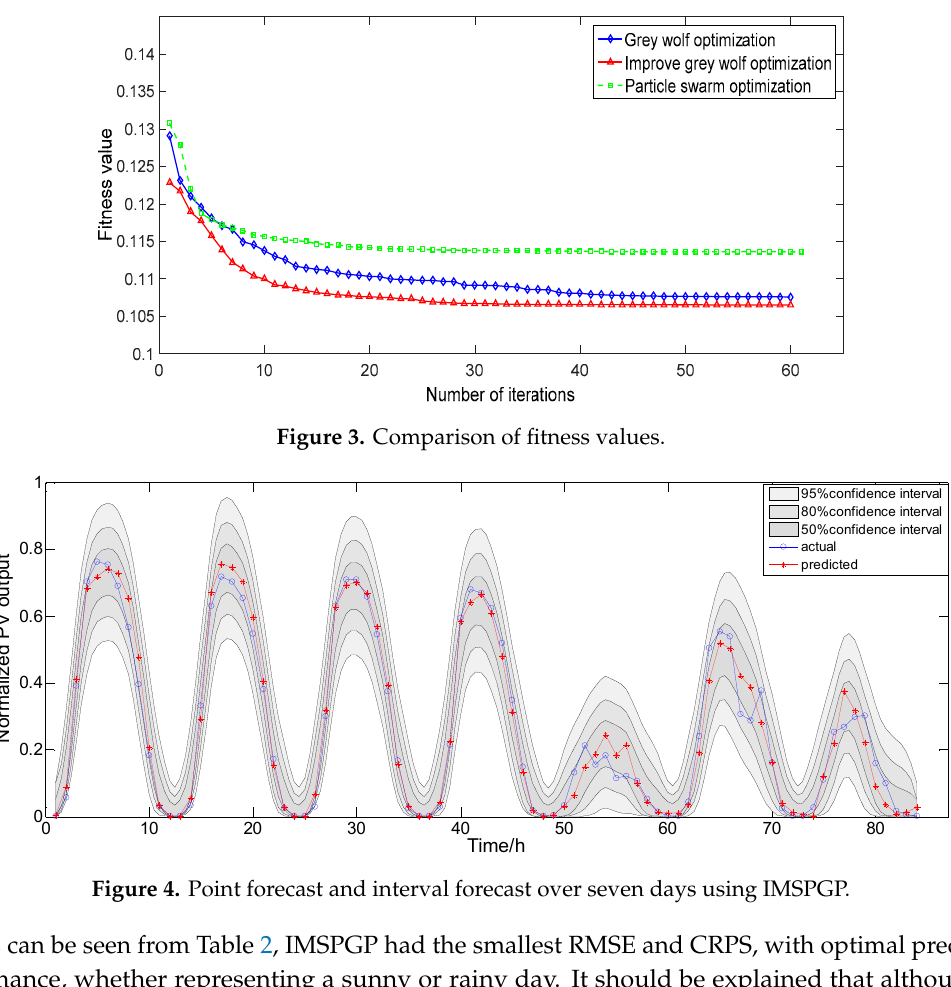
Table 2. Prediction results of GP, SPGP, and IMSPGP models for May.